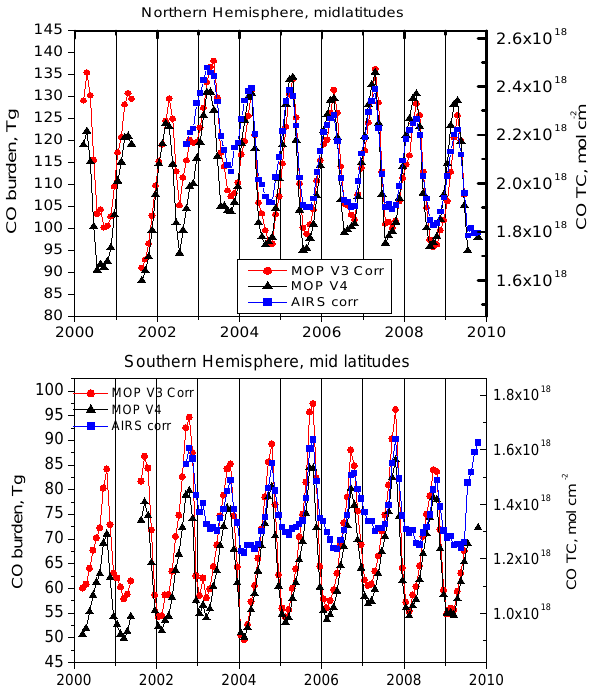
Fig. 8. Comparison of CO total burdens measured by two sounders over the Northern and Southern Hemispheres in the same latitudinal belts as in Fig. 7. Note the general good agreement between our corrected MOPITT V3 and the new MOPITT V4.